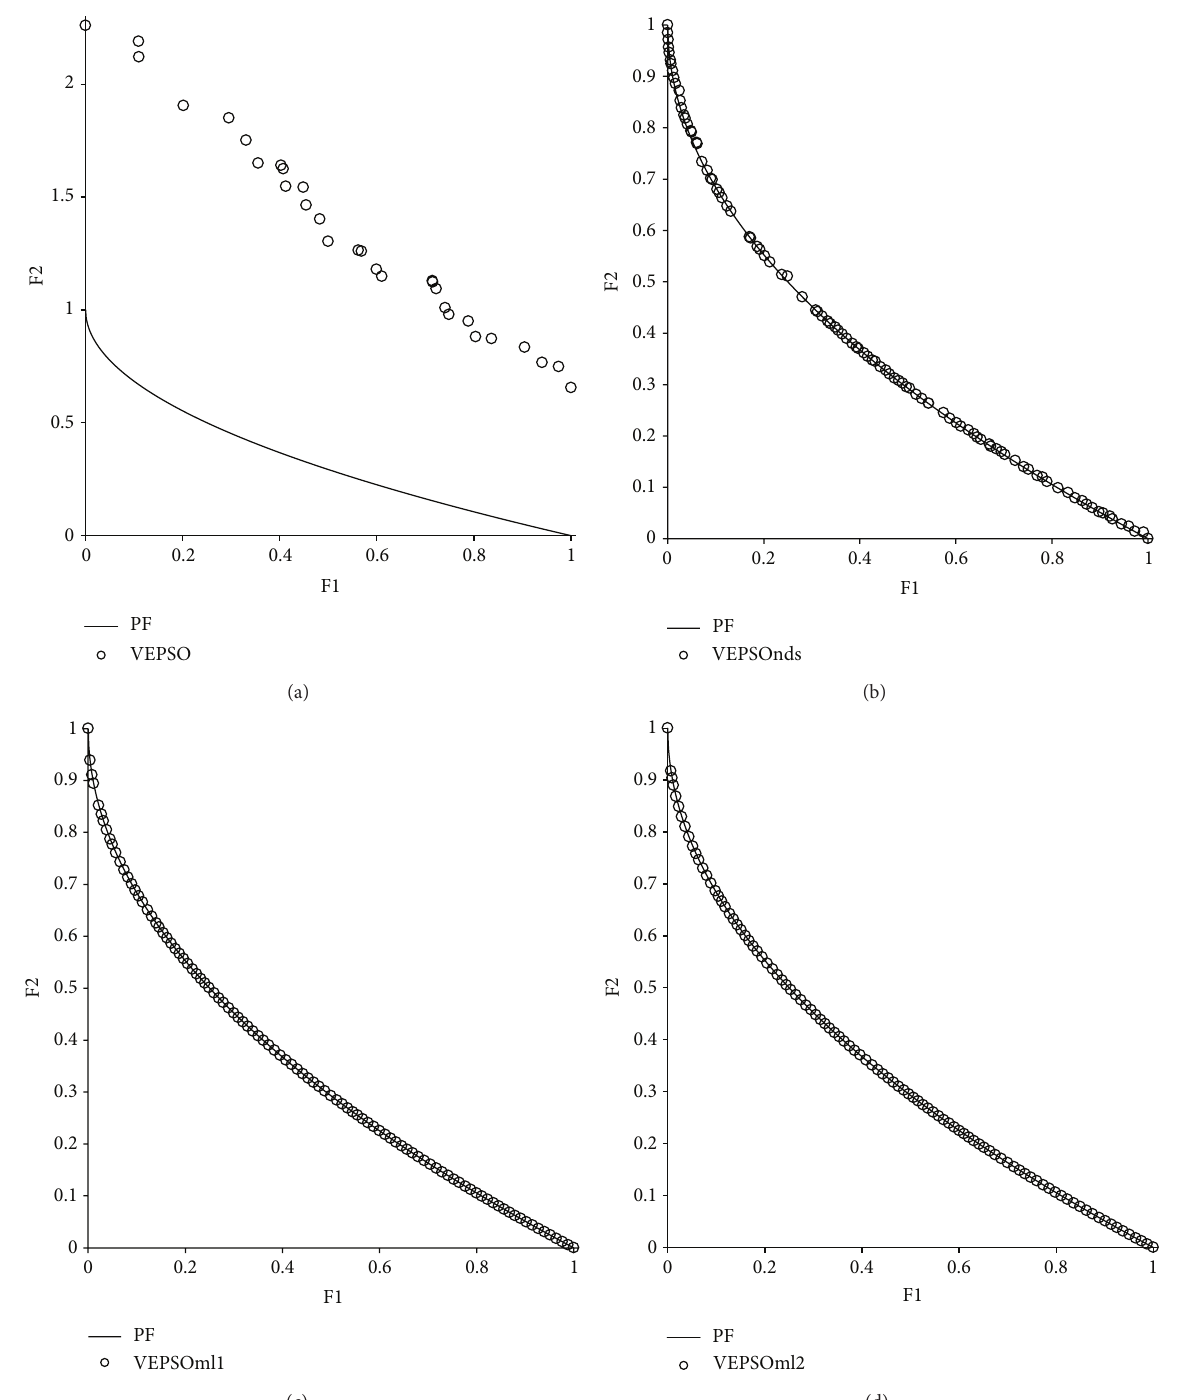
Figure 6: Plot of nondominated solutions returned by each algorithm for the ZDT1 test problem.